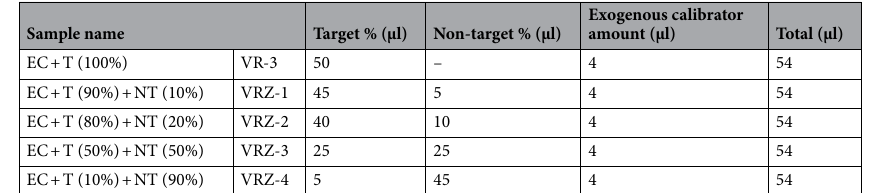
Table 3. Engineered DNA mix ratios prepared for the quantification of target A. racemosa. DNA T target DNA, NT non-target DNA, EC exogenous calibrator DNA.